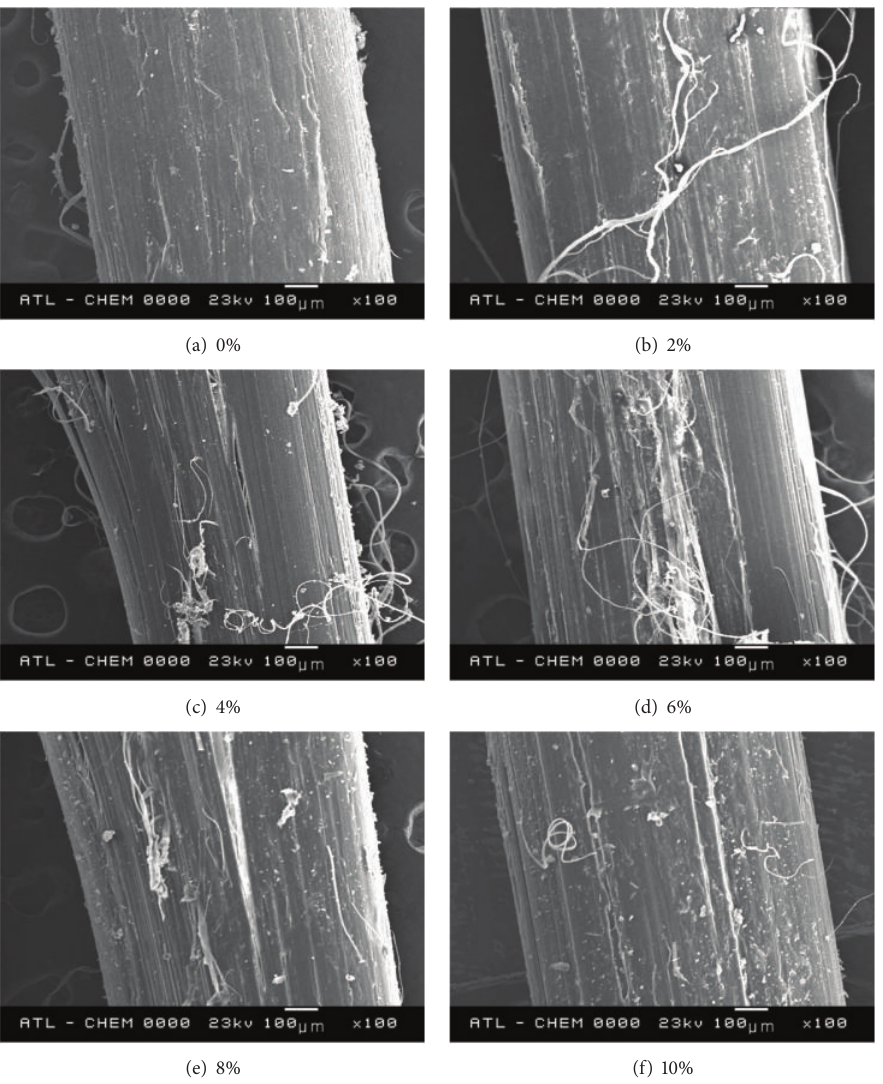
Figure 9: SEM investigation of macro PP fiber surface in LCC with nanosilica